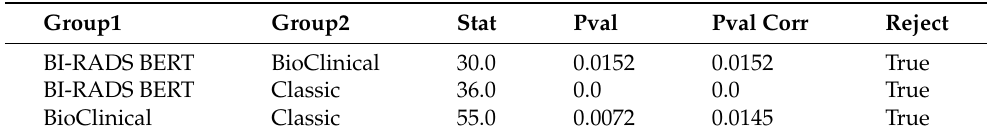
Table A14. Bonferonni-corrected McNemar test results for field extraction with no section segmenta- tion of density.